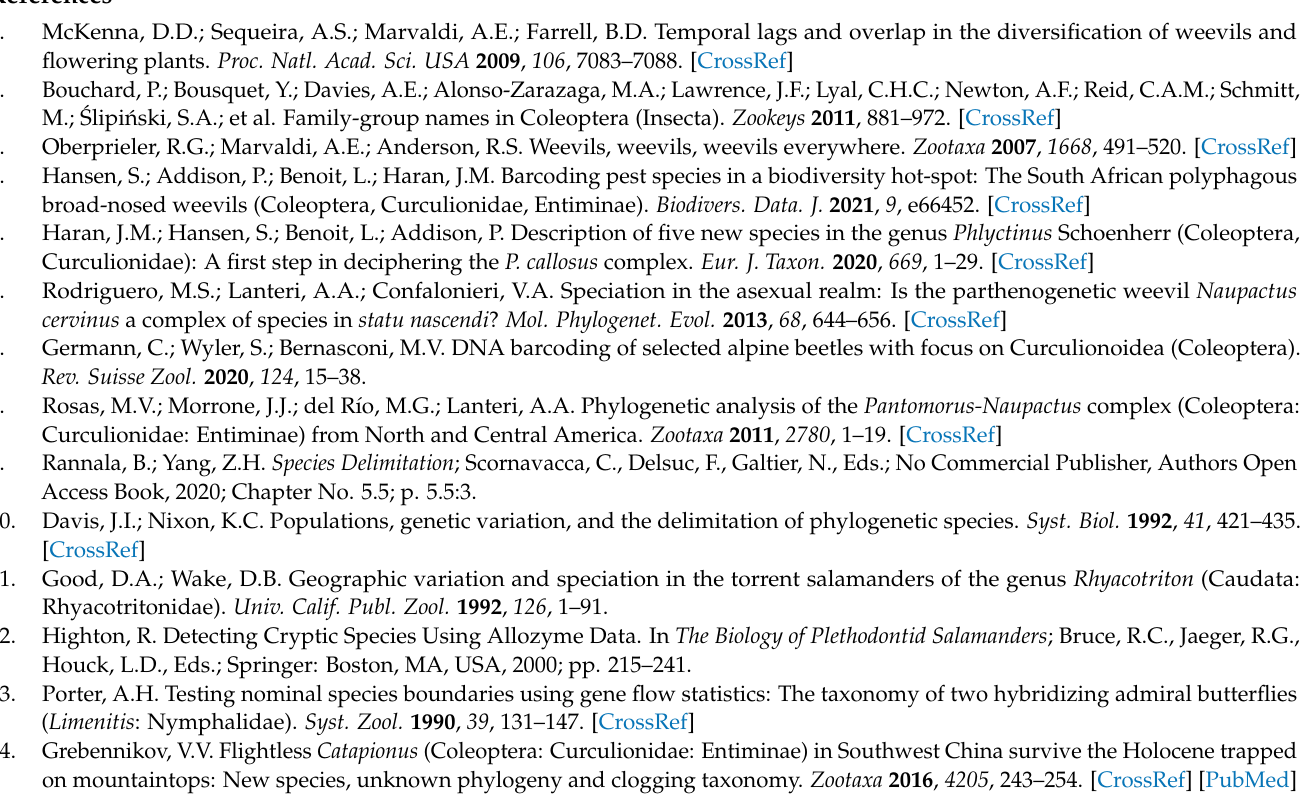
screening sequence and species, Table S3: Sequences of Dataset I, Table S4: Specimens information of sequencing data, Table S5: Sequences of Dataset II, Table S6: Intraspecific and interspecific genetic distance, distance threshold for species delimitation, Table S7: The maximum intraspecific and minimum interspecific genetic distances of Entiminae species in Dataset I, Table S8: The maximum intraspecific and minimum interspecific genetic distances of Entiminae species in Dataset II, Table S9: The maximum intraspecific and minimum interspecific genetic distances of Entiminae species in Dataset III, Table S10: The distance threshold for 14 selected genera in Dataset III, Table S11: Primers of COI-5’ sequence of weevils in BOLD